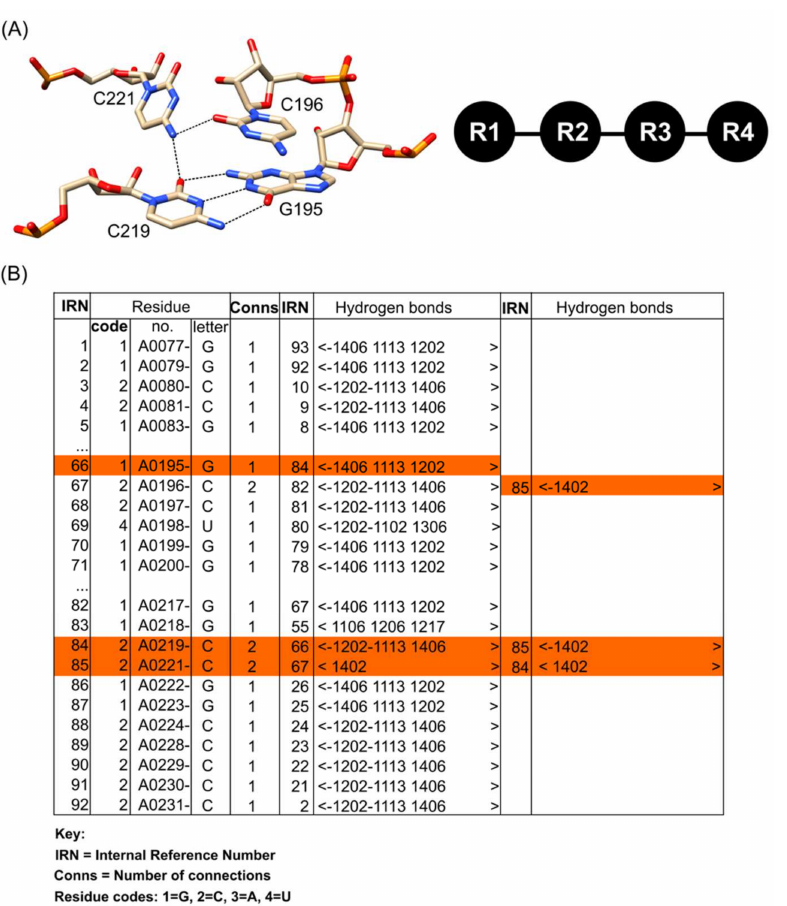
Figure 5. ( A ) A base quadruple inter-connected by hydrogen bonds (left panel), represented as a tree graph (right panel). ( B ) Hydrogen bonds computed and arranged as a connection table, with the hydrogen bonds involved in the four-base network highlighted in